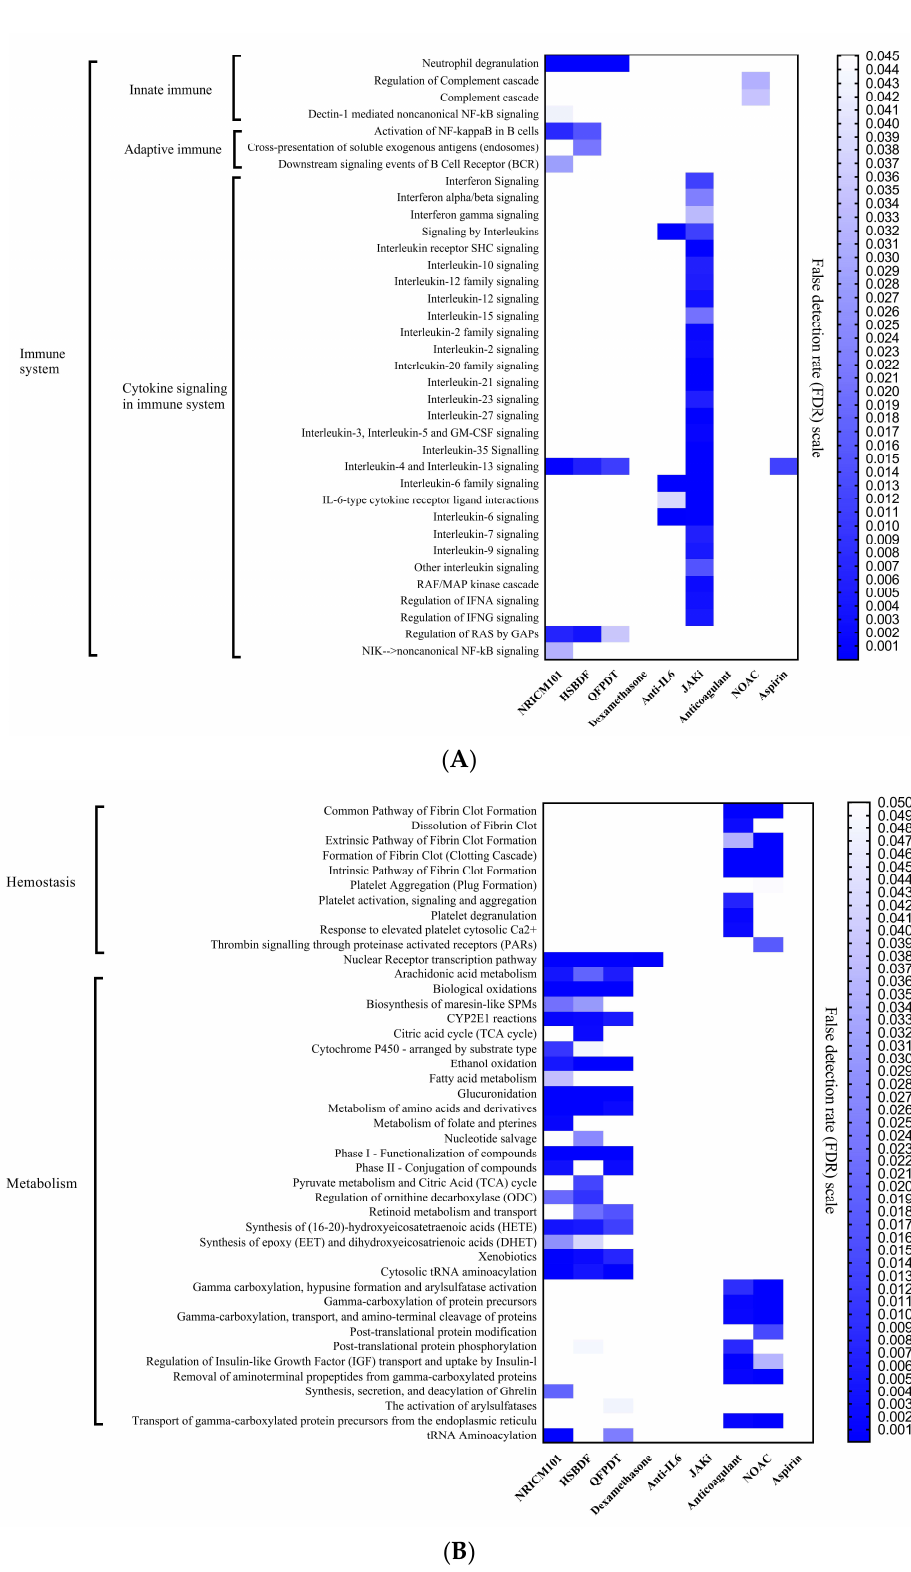
Figure 6. The differences in molecular pathways between CHM and WM. ( A ) The immune system- related molecular pathways. ( B ) The hemostasis and metabolism-related molecular pathways. To understand the shared and different mechanisms in the three CHM, Figure 7 com- pares the molecular pathways of these three drugs in the immune system as well as me- tabolism and signal transduction (for details, see Supplementary material S7). NRICM101